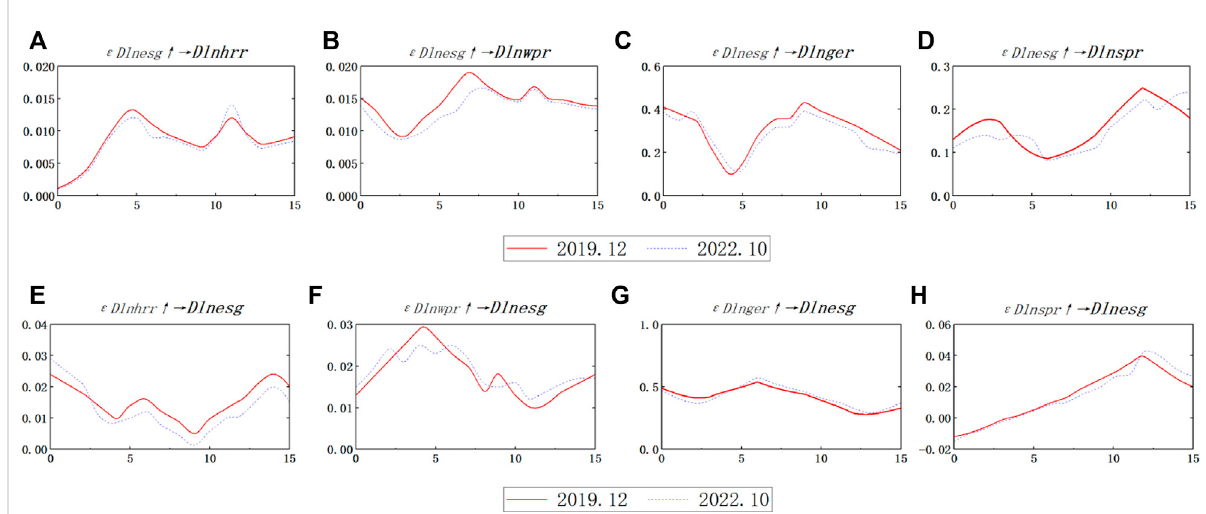
FIGURE 11 Time-point impulse response graphs. the point-in-time impulse responses of sustainable development to (A) geothermal, (B) hydro, (C) solar, and (D) windenergy,theimpulseresponseof (E) hydroand (F) solarenergytosustainabledevelopmentofthetime-pointimpulseresponseplots, (G) the time-point impulse response of wind energy to sustainable development, and (H) the impulse responses of geothermal energy to sustainable